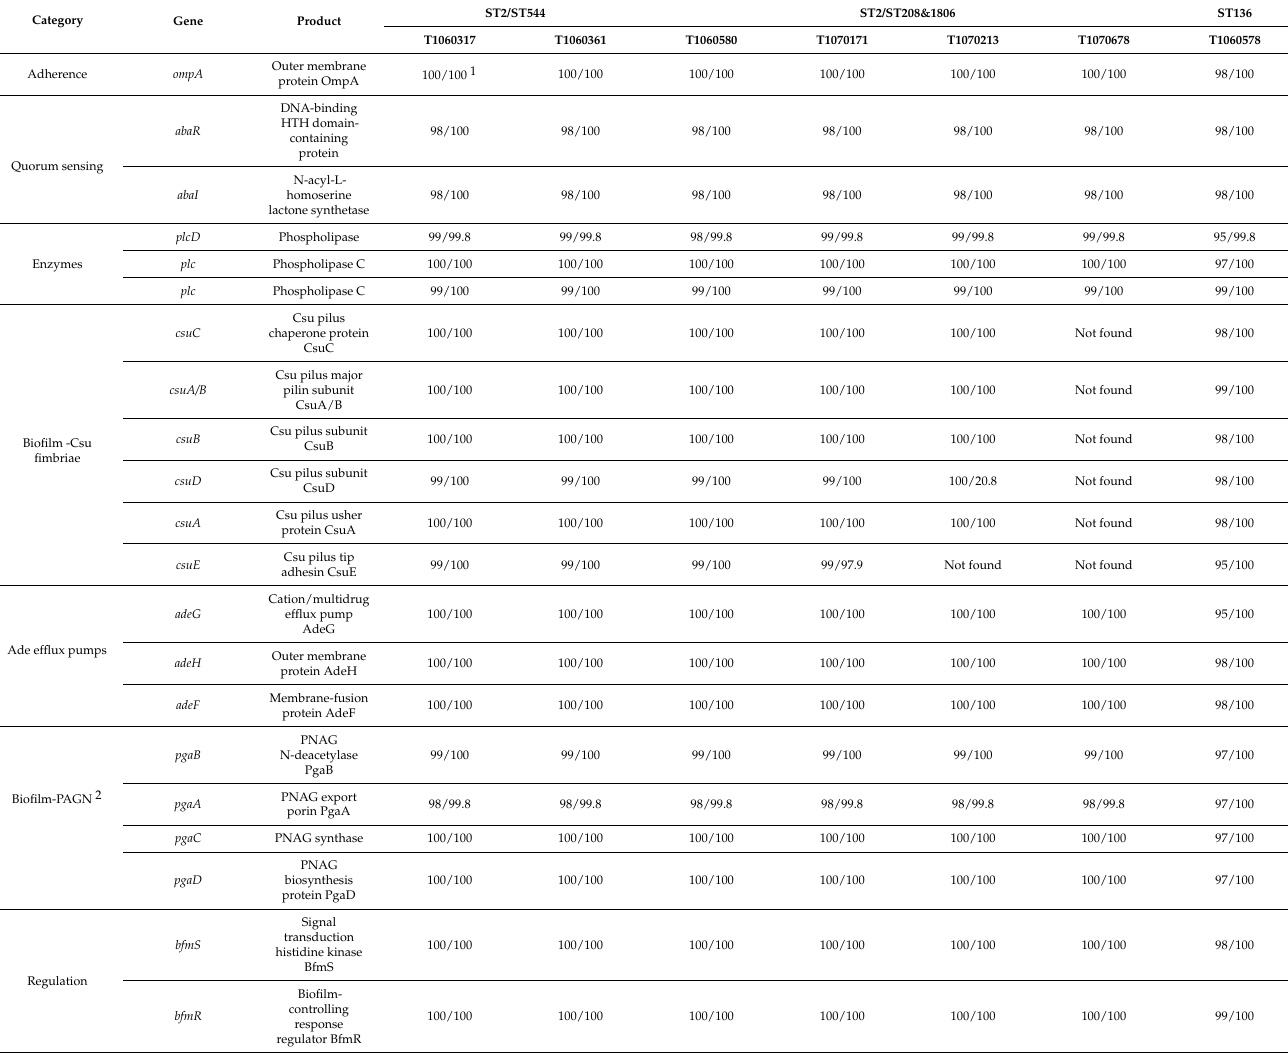
Table 3. In silico detection of virulence factors in the CCR-AB